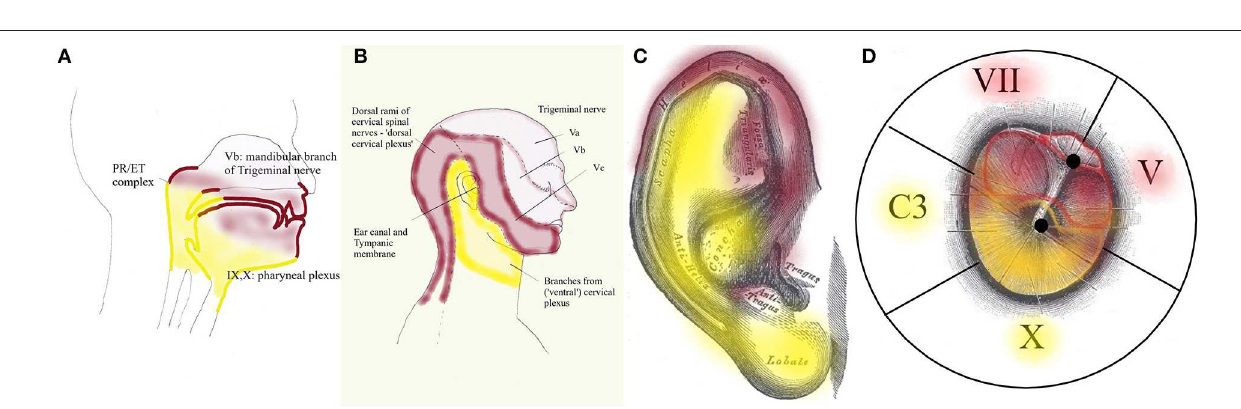
FIGURE 10 | Dermatomes innervated by dTCC (red) and vTCC (yellow). The “demarcation line” runs in the pharynx (A) through the PR/ET complex, nasopharyngeal region, palate, tongue base; externally (B) along the mandibula, through the pinna (from Gray’s anatomy via Wikipedia) (C) , external ear canal and TM (propriocepsis of the mimic muscles is carried by the Vth nerve) (D) . Symptoms related to dTCC/vTCC activation and muscular tensions rigorously respect these